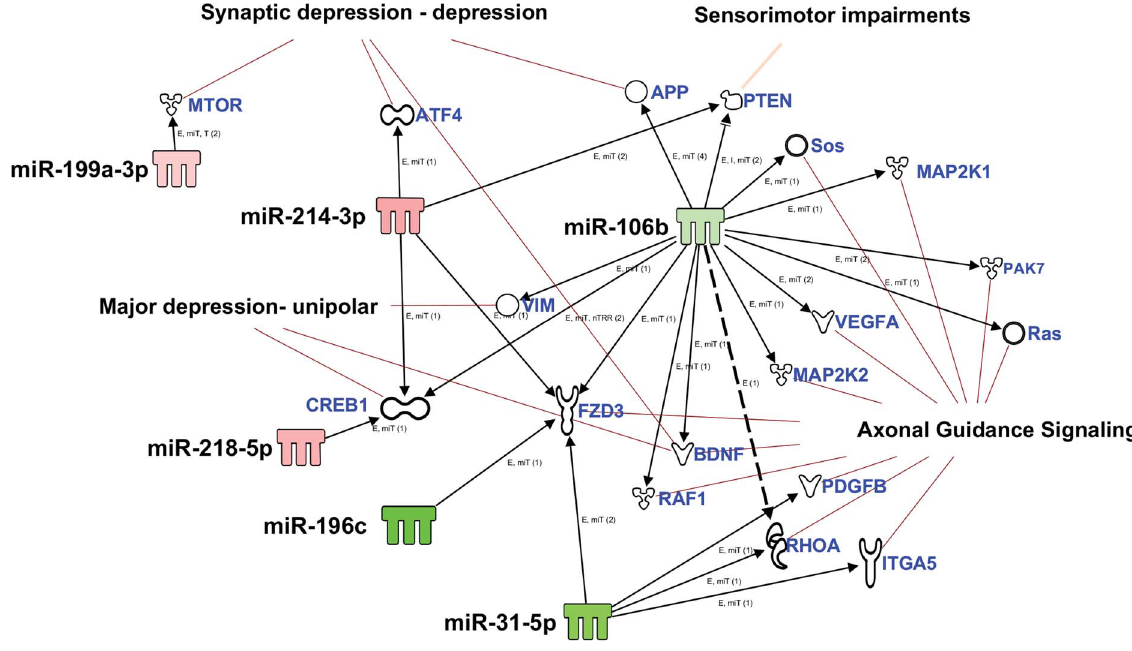
Figure 6. IPA Analysis for effect of significantly modulated miRNAs common among all four injury groups on brain functions related pathways. MiRNAs common to all four injury groups were taken and their targets and pathway analysis in relation to brain related functions were performed. My Pathway tool of IPA software was used to build the custom pathway using miRNAs that show experimentally validated targets by overlaying with 1) depression, 2) sensorimotor function and the 3) axon guidance pathway molecules. Of the 13 common modulated miRNAs, only 6 miRNAs were found to have experimentally validated targets that are predicted to modulate axon guidance, synaptic depression and sensorimotor impairments.